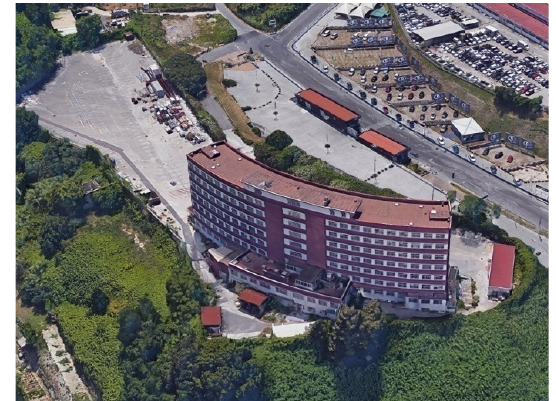
Figure 1: View of the building (Google Earth).